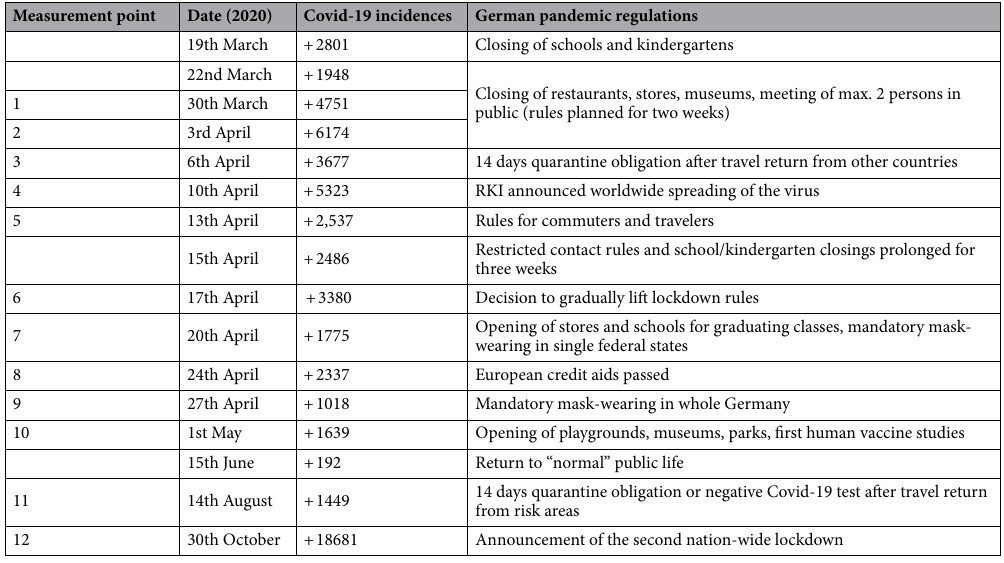
Table 1. Pandemic regulations in Germany during the survey period, adapted from Imöhl and Ivanov 36 . The regulations came into force either on the measurement point/date indicated or in the period between two measurement points/dates. The incidences were published by the Robert Koch Institute (RKI) at the given measurement point/date.